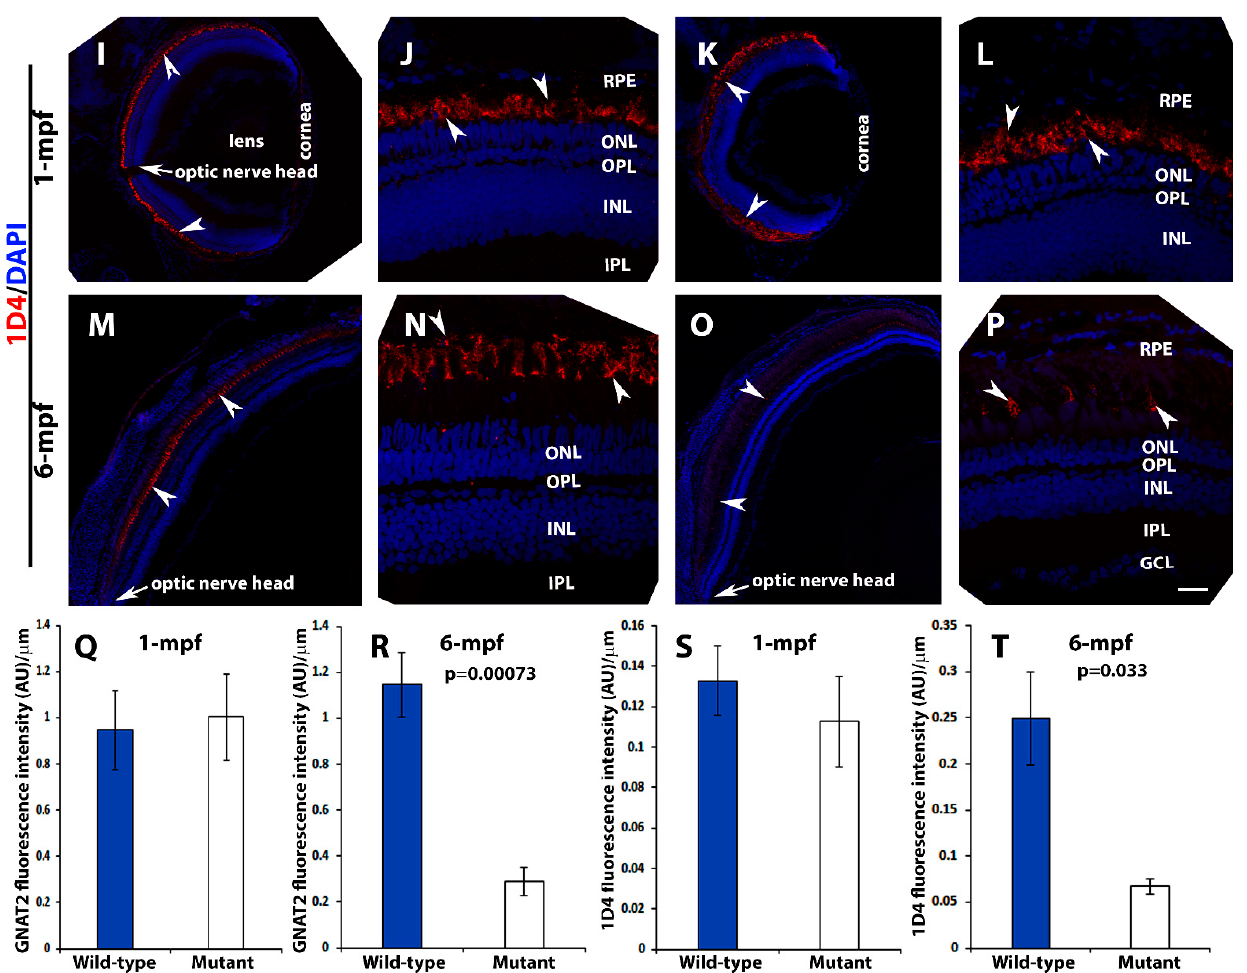
Figure 6. Loss of photoreceptors in pomt2 mutant retinas at 6-mpf but not 1-mpf. Zebrafish reti- nal sections at 1-mpf and 6-mpf were immunostained with GNAT2 antibody (green fluorescence, A – H ) and 1D4 (red fluorescence, I – P ). The sections were counter-stained with DAPI. To quan- tify loss of cone photoreceptors, GNAT2 and 1D4 immunoreactive intensities were measured ( Q – T ). ( A , B ) Wild-type GNAT2 immunostaining at 1-mpf. ( C , D ) Homozygous pomt2 sny5+13 mu- tant GNAT2 immunostaining at 1-mpf showing similar immunoreactivity compared to the wild-type. ( E , F ) Wild-type GNAT2 immunostaining at 6-mpf. ( G , H ) Homozygous pomt2 sny5+13 mutant GNAT2 immunostaining at 6-mpf showing reduced immunoreactivity compared to the wild-type. ( I , J ) Wild- type 1D4 immunostaining at 1-mpf. ( K , L ) Homozygous pomt2 sny5+13 mutant 1D4 immunostaining at 1-mpf showing similar immunoreactivity compared to the wild-type. ( M , N ) Wild-type 1D4 im- munostaining at 6-mpf. ( O , P ) Homozygous pomt2 sny5+13 mutant 1D4 immunostaining at 6-mpf showing reduced immunoreactivity compared to the wild-type. ( Q ) GNAT2 immunofluorescence intensity (artificial units, AU) quantification of wild-type and mutant fish at 1-mpf ( n = 3). There was no significant difference between wild-type and mutant retinas. ( R ) GNAT2 immunofluorescence intensity quantification of wild-type and mutant fish at 6-mpf ( n = 3). GNAT2 immunoreactivity was significantly reduced in mutant retinas. ( S ) 1D4 immunofluorescence intensity quantification of wild-type and mutant fish at 1-mpf ( n = 3). There was no significant difference between wild-type and mutant retinas. ( T ) 1D4 immunofluorescence intensity in the mutant retina was reduced at 6-mpf ( n = 3). Arrowheads indicate examples of GNAT2 immunoreactivity (A-H) and 1D4 immunoreactiity (I-P). Arrows indicate location of optic nerve heads. Scale bar in P: 100 µ m for all low magnification panels and 18.7 µ m for all high magnification